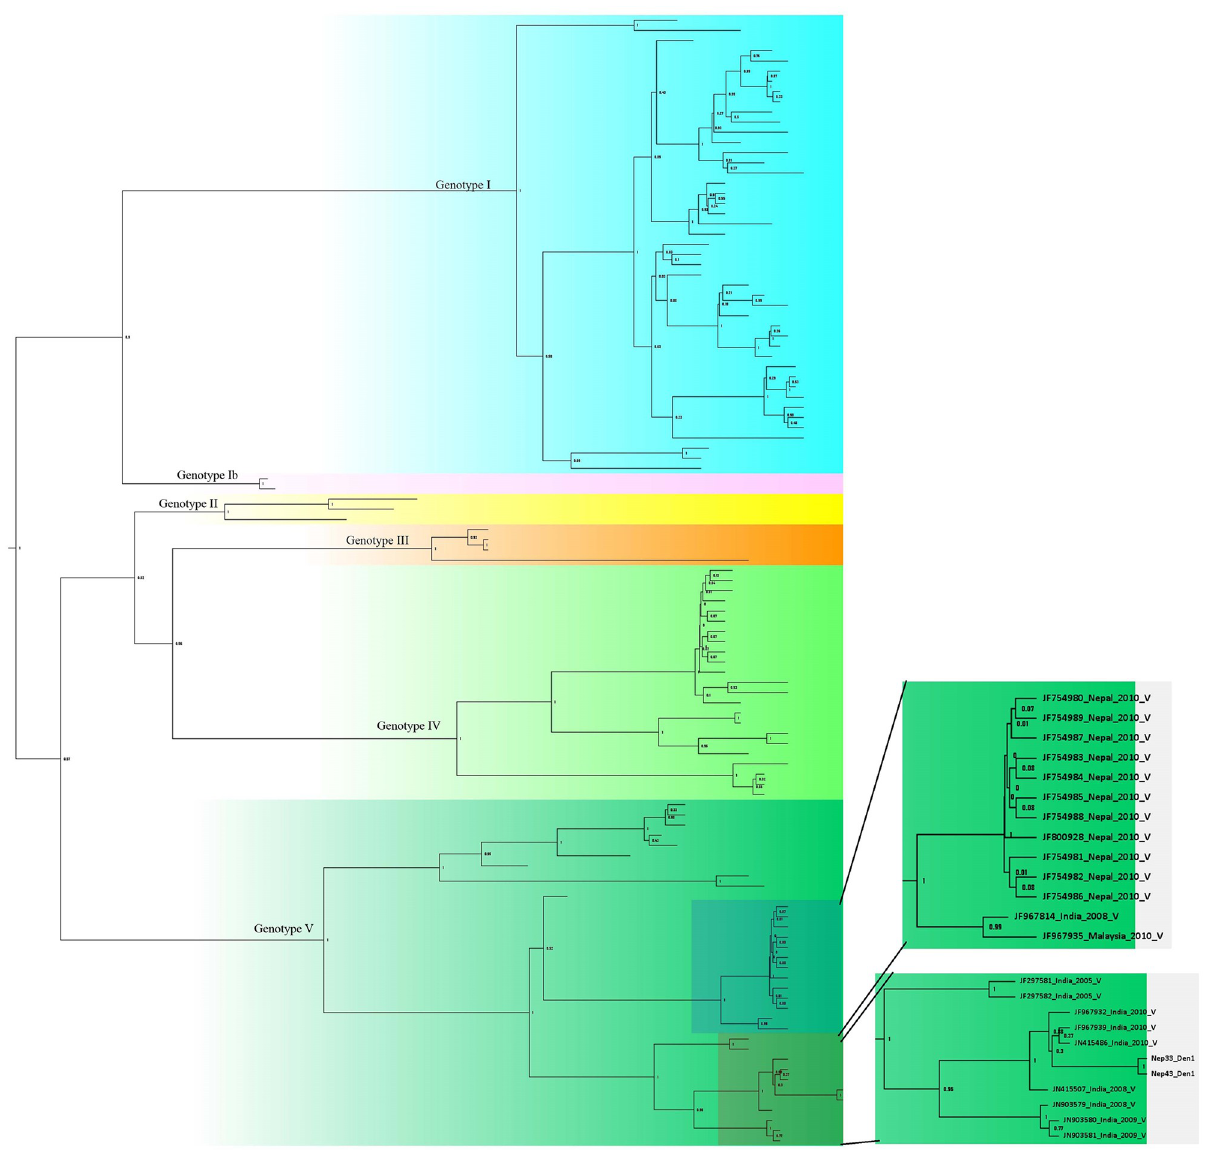
Fig 4. Phylogenetic tree of DENV-1 isolates. The two sections to the right show enlarged images of the lower left boxes containing the Nepal sequences from the present study. Sequences are labeled by accession number, country, year of isolation, and genotype. Tree is labelled with posterior probability at node. Detail tree with all of the sequences used for genotyping is shown in S1 Fig. Constructed using BEAST v2.5.1 with Gamma+I+T93 substitution modeled against the DENV genotyping database.